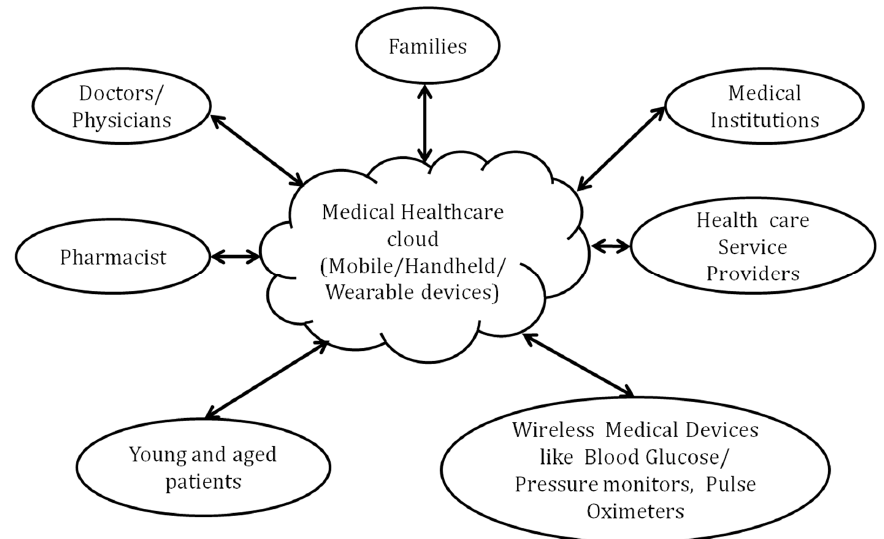
Figure 10. Healthcare cloud services.